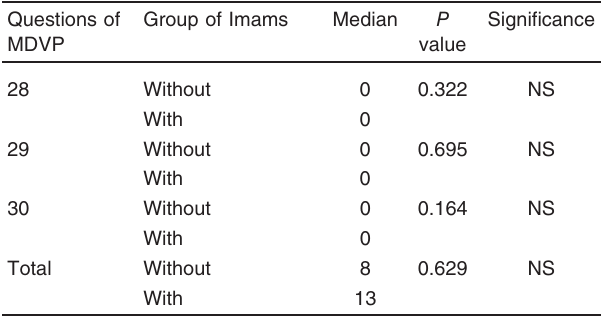
Table 5 Comparison between the results of the first group and the control group according to the VHI questions in